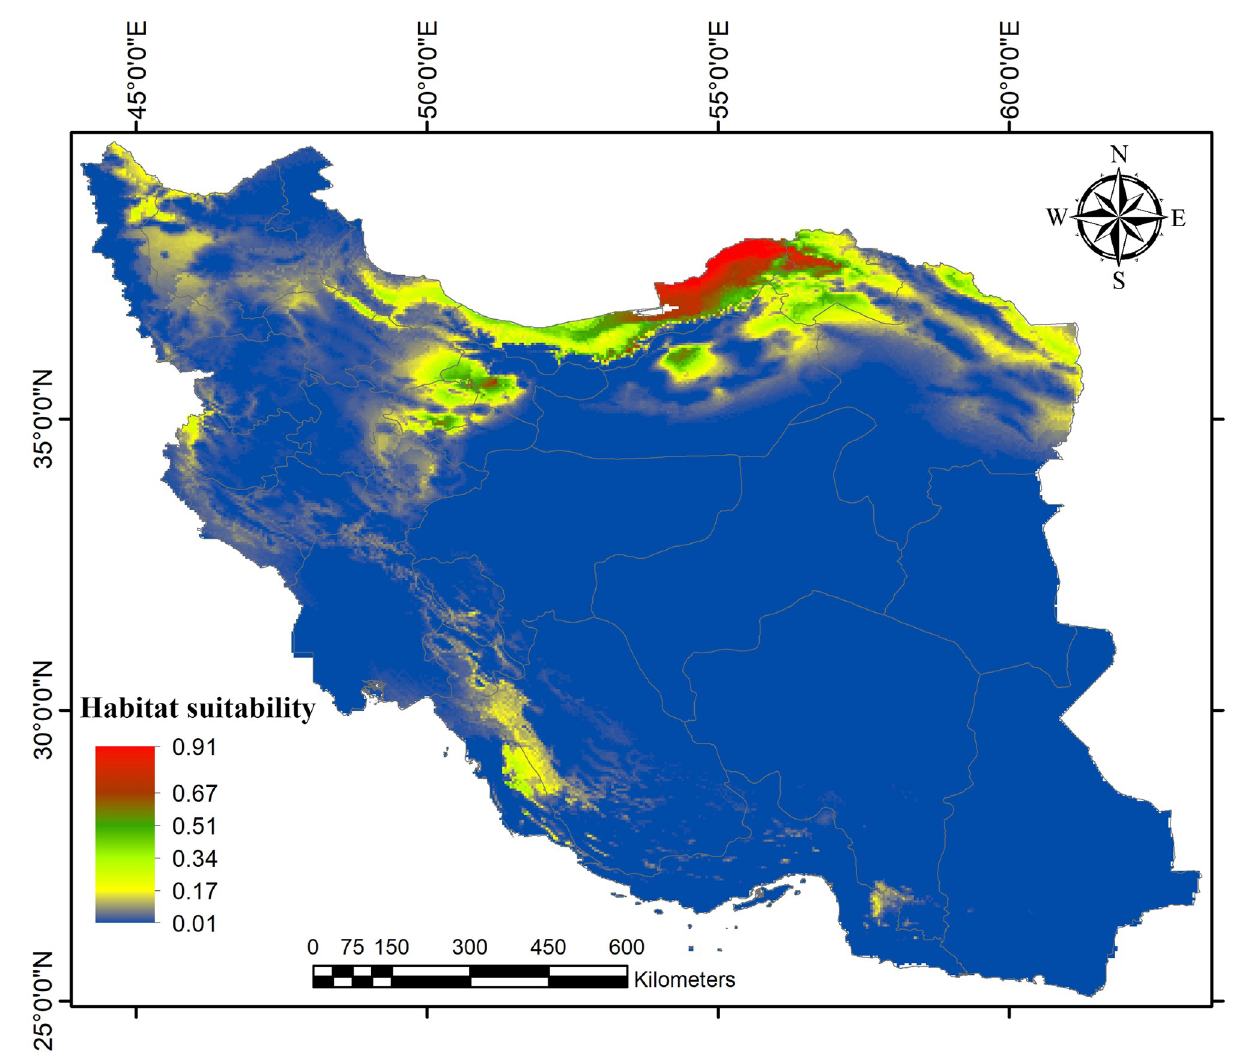
Fig 3. Predictive distribution map of Rhombomys opimus sodalis in MAXENT